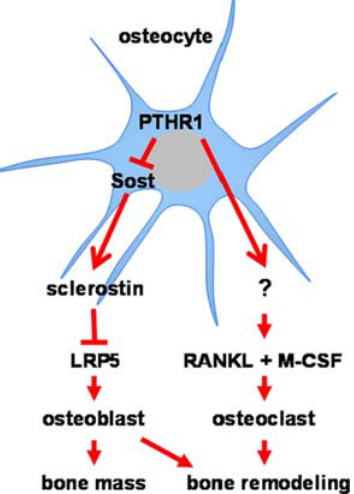
Figure 7. PTHR1 Signaling in Osteocytes Leads to Increased Bone Mass and Remodeling via Distinct Mechanisms. In the proposed model, PTHR1 signaling in osteocytes activates at least two distinct pathways: one leading to increased bone mass and the other leading to increased bone remodeling. Suppression of Sost/sclerostin and activation of LRP5 signaling increase osteoblast numbers and are required for the increase in bone mass. The elevation of bone resorption is independent of the Sclerostin/LRP5 pathway. The question mark indicates uncertainty of the cellular source of RANKL and M-CSF (osteocytes versus stromal/osteoblastic cells).